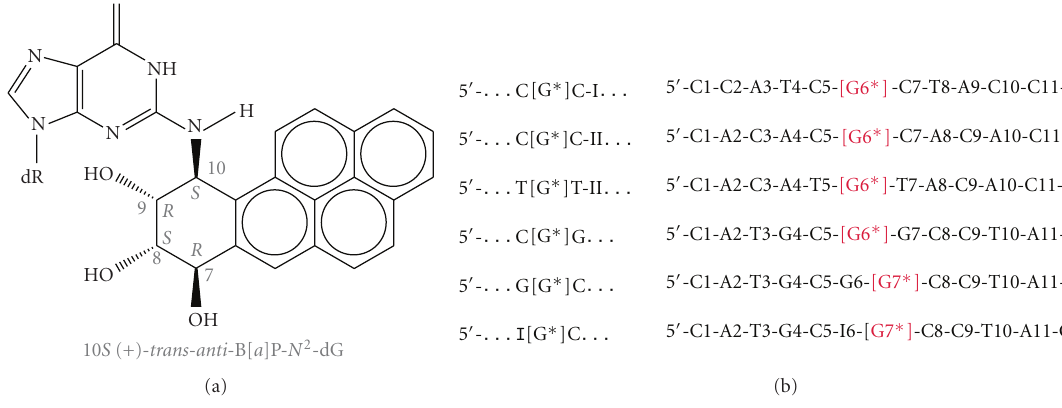
Figure 1: (a) Chemical structure of the 10 S (+)- trans - anti -B[ a ]P- N 2 -dG adduct. (b) Base sequence contexts investigated. For 5 (cid:3) - ... I [G ∗ ]C ... , formally, inosine is the nucleoside, while hypoxanthine is the correct name for the corresponding base; for simplicity we utilize the term inosine.